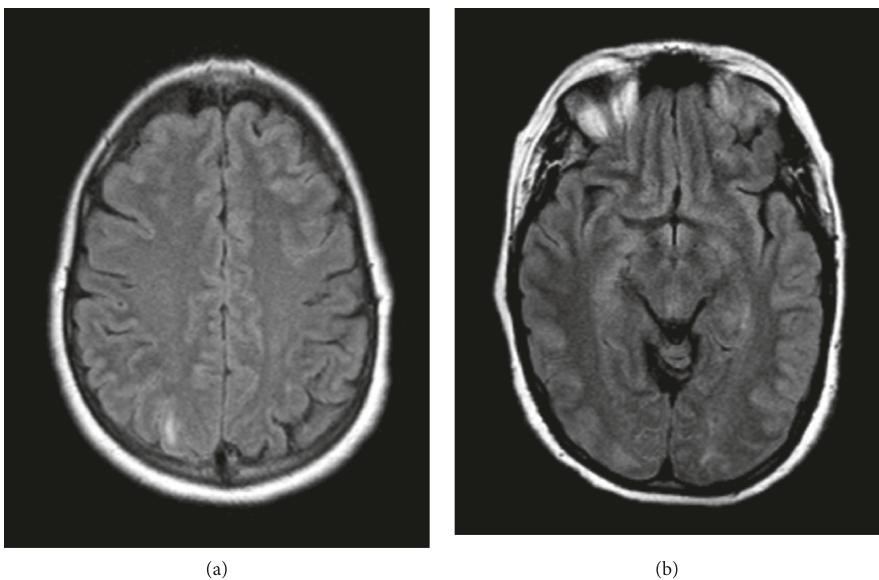
Figure 2: Axial FLAIR images of the brain demonstrating hyperintense signals in the (a) posterior right parietal lobe and (b) posterior occipital lobes